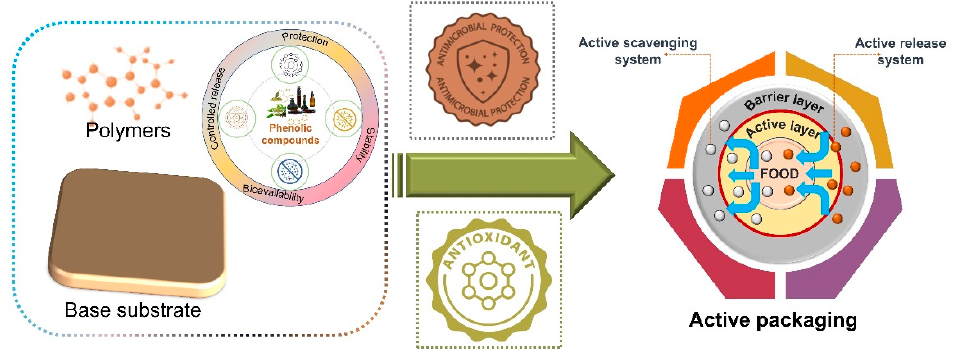
Figure 2. Graphical depiction of antioxidant and antimicrobial properties of phenolic compounds in the development of an active-packaging system.